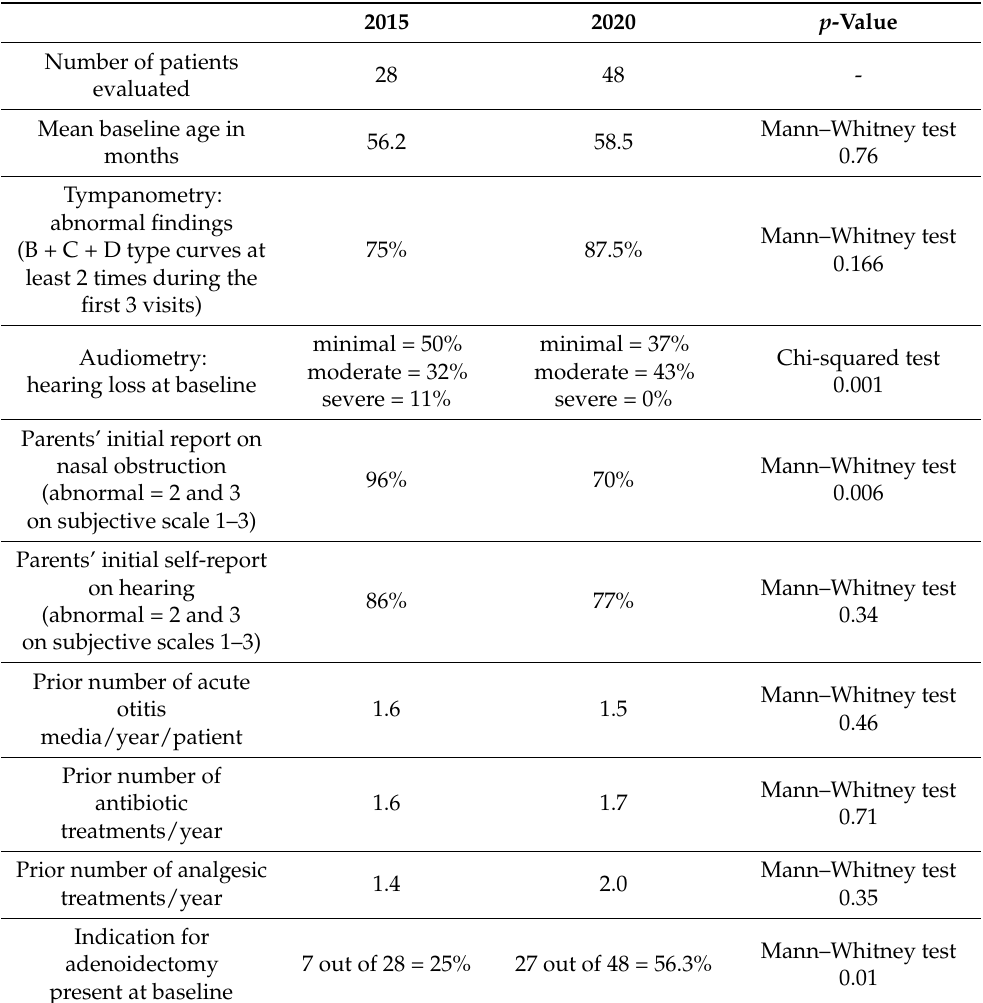
Table 3. Baseline